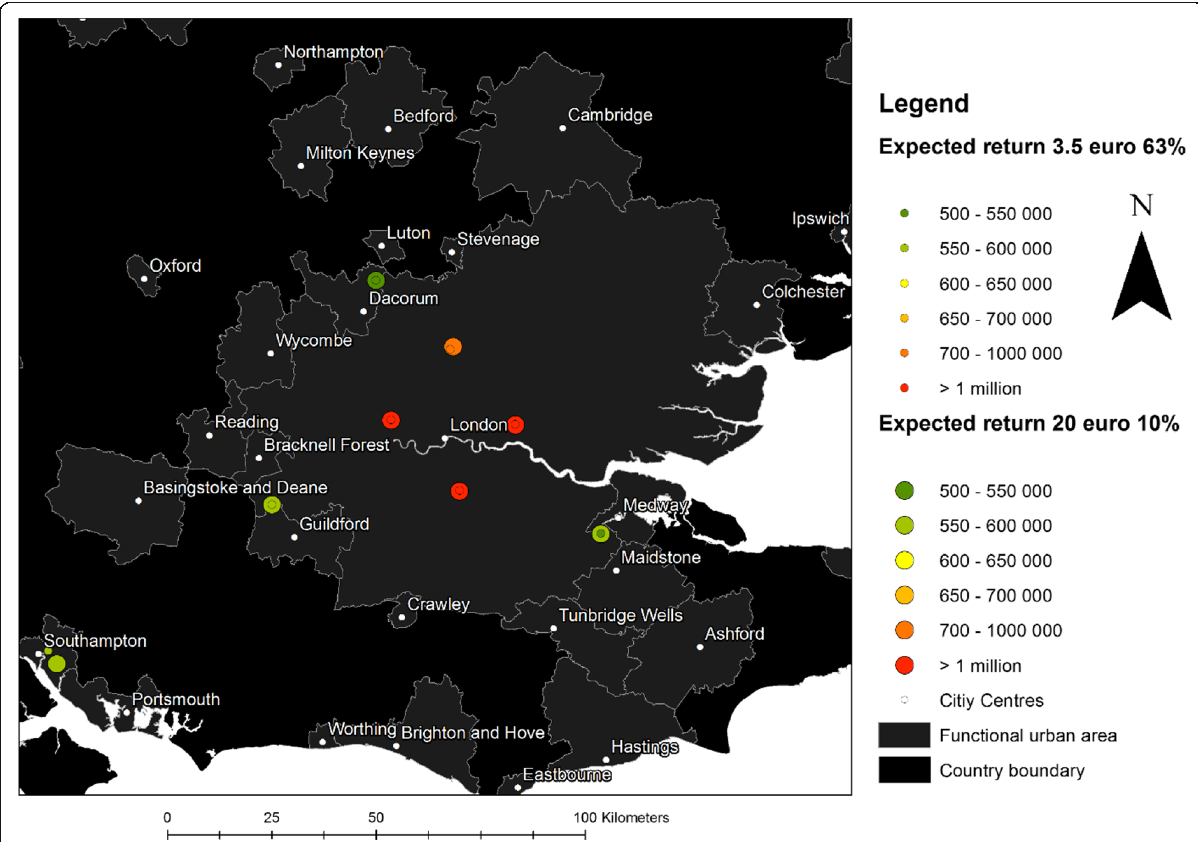
Fig. 20 Comparison in the spatial distribution of drone-beehives for Scenario 1 between an Item Price Margin of 20 euro and 10% reach of potential customers (large circles) and an Item Price Margin of 3.5 euro and 65% reach of potential customers (small circles), for the area of